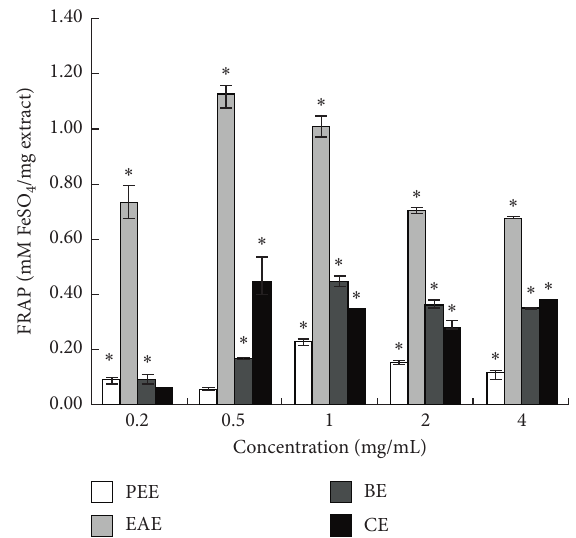
Figure 3: FRAP value (FeSO 4 mM/mg extract) of four extracts. ∗ P < 0 . 05 vs. the blank